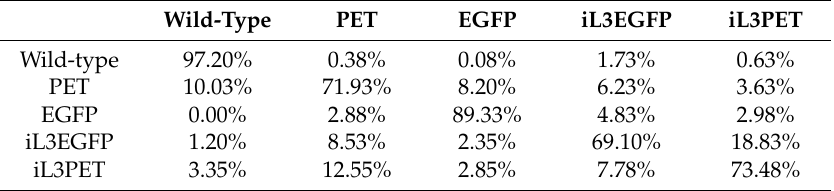
Table 1. PLS predictions of the riboswitch set. Confusion matrix of strain prediction using structured output .